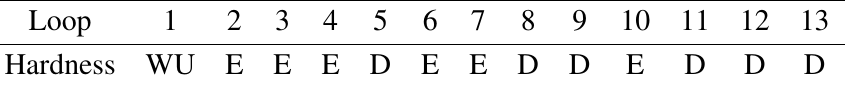
Table 4. Course profile of a training session.